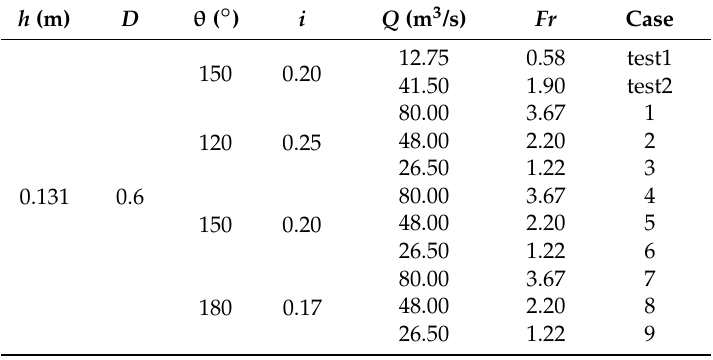
Table 1. Summary of the operating conditions for the